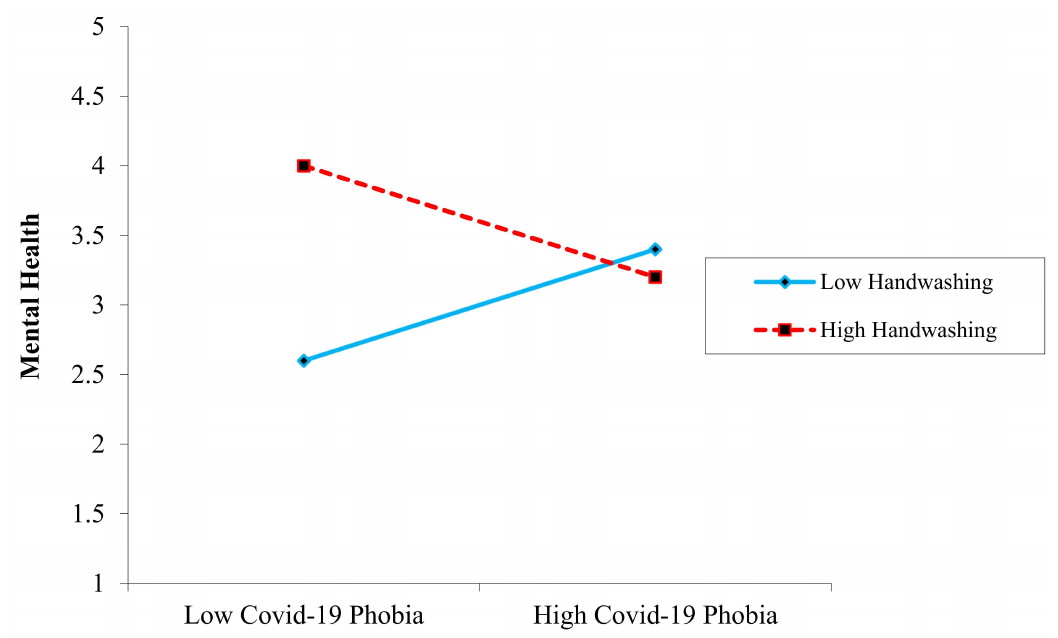
Figure 2. Moderating the role of handwashing on the relationship between COVID-19 phobia and mental health.